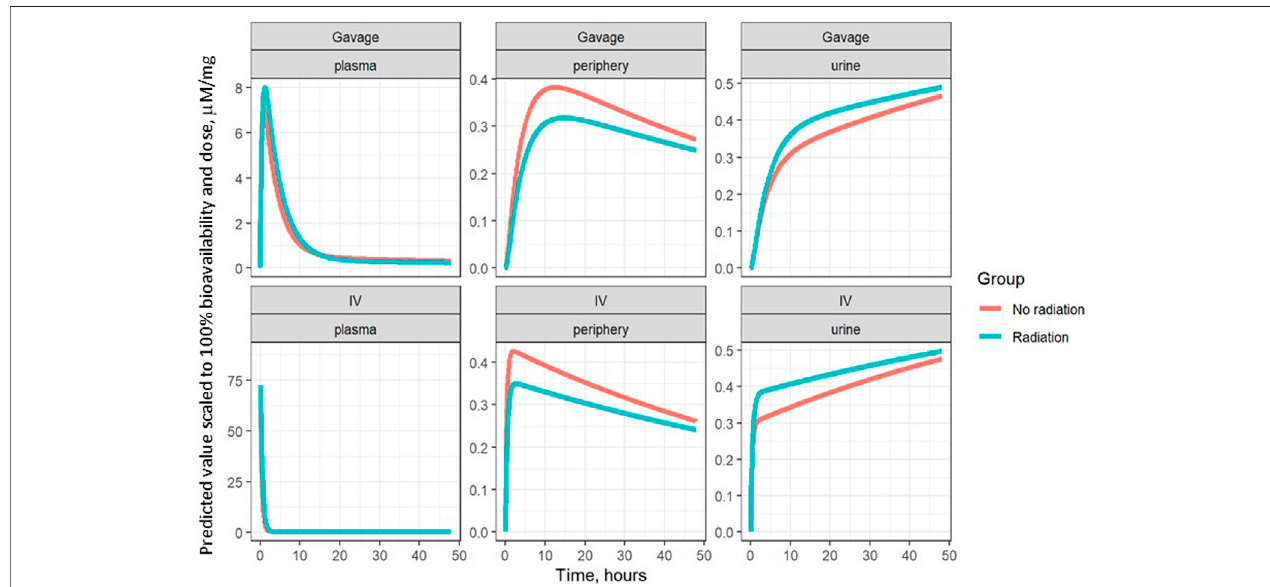
FIGURE 4 | Model-inferred estimates for lisinopril over time in plasma, lungs, and urine, adjusted for bioavailability, broken out by delivery technique.